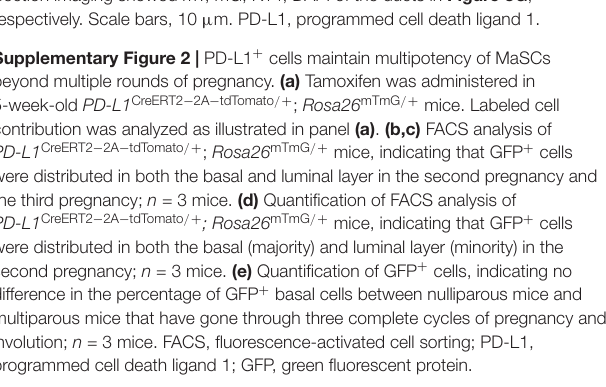
Supplementary Figure 4 | PD-L1 expression pattern during various mammary development stages of wild-type mice. (a) FACS analysis of PD-L1 + basal cells in mammary glands of pubertal (5–6 weeks) wild-type mice; n = 3 mice. (b) FACS analysis of PD-L1 + basal cells in mammary glands of adult (8–12 weeks) wild-type